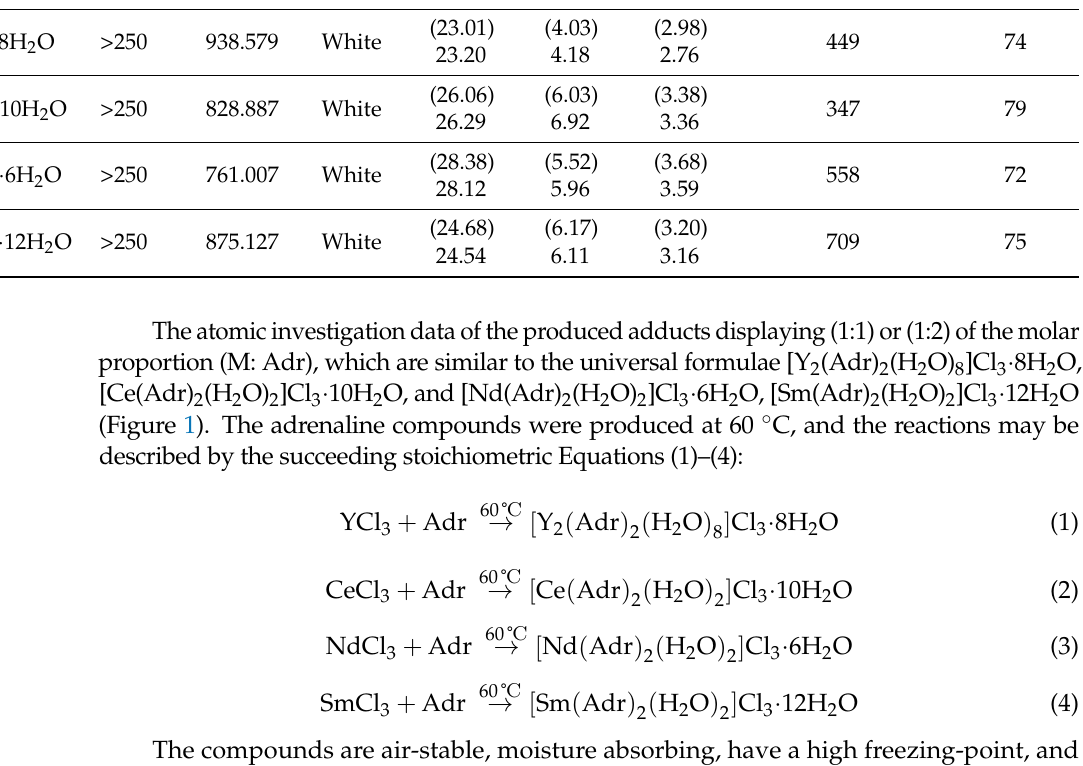
Elemental Analysis (%) M.Wt, Found (Calcd.) Color g/mol C H